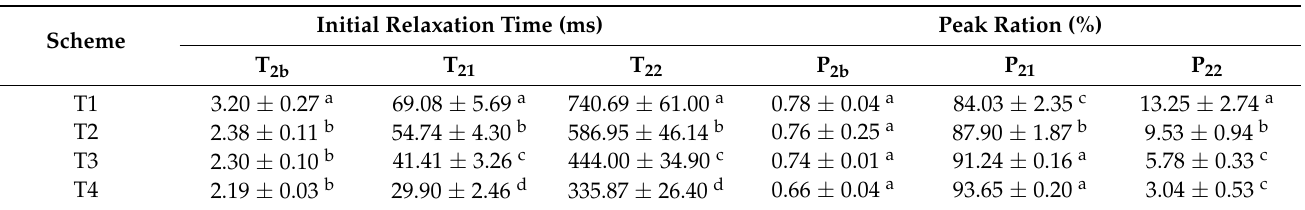
Table 2. The changes in initial relaxation time (ms) and peak ratio (%) of the PSE meat myofibrillar protein gels with varying amounts of added sodium bicarbonate.